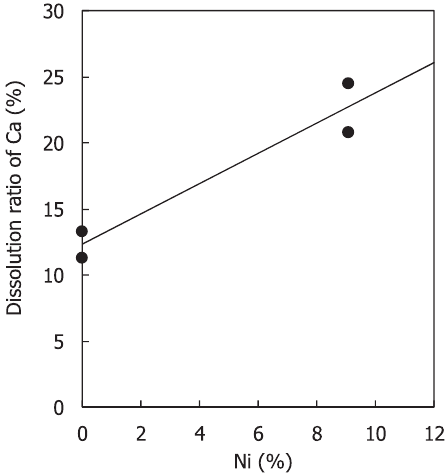
Fig. 3: Influence of nickel concentration on dissolution ratio of calcium in molten steel.